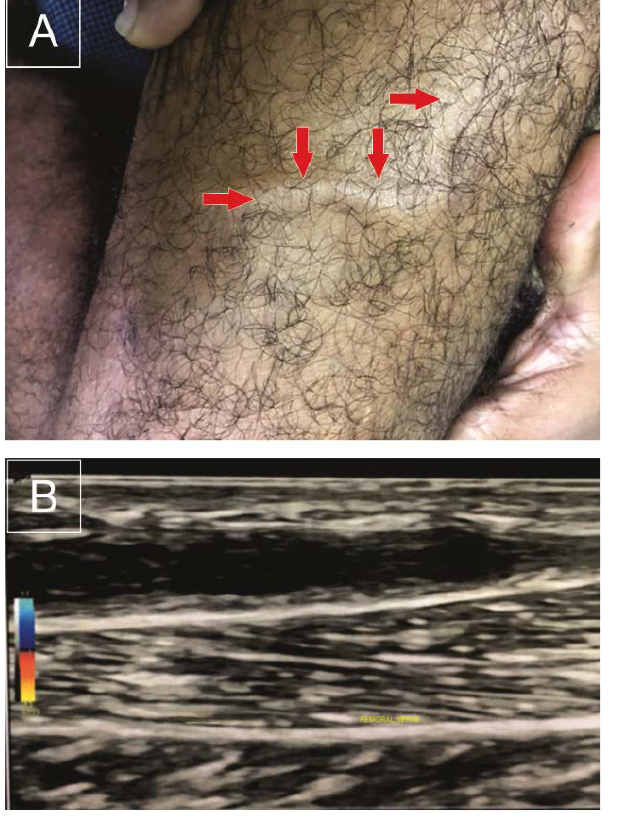
Figure 1. A) Thickening of the superficial femoral cutaneous nerve (arrows); B) ultrasonographic image.